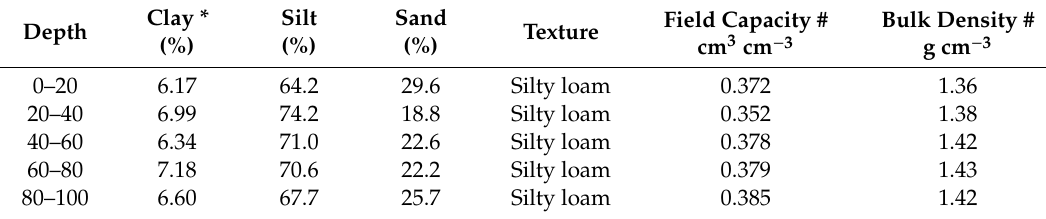
Table 1. Soil texture and hydraulic characteristics in the upper 100 cm soil layer.